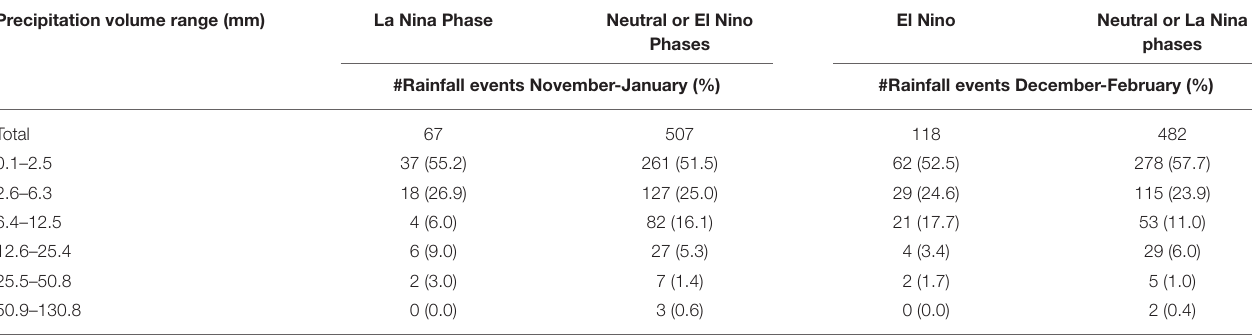
TABLE 6 | Comparing rainfall volume distribution in November, December, and January during La Nina years to those during Neutral and El Nino phases and in December, January, and February during El Nino phases to those during Neutral and La Nina phases. Precipitation volume range